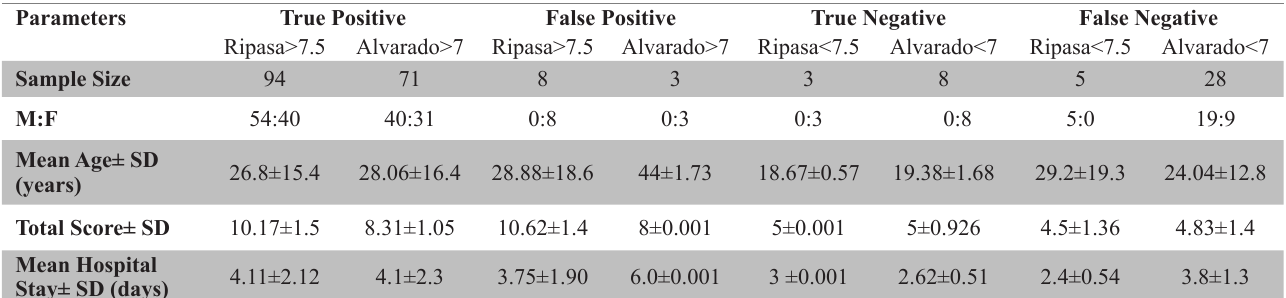
Table 3. Patient distribution according to RIPASA and Alvarado scores